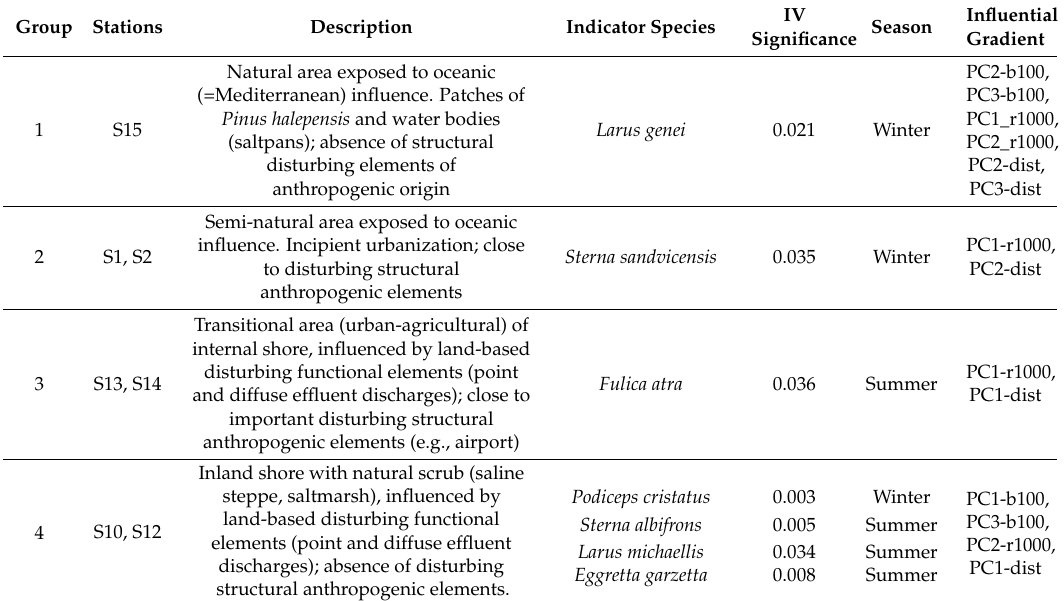
Table 3. Sampling stations grouped by Cluster classification (structural-functional groups) from the first three axes of all the PCAs performed. Also shown are the Indicator Species for each group (from IndVal analyses), the season when the indicator value is statistically significant and the influential environmental gradients (PCs) for each species (clear association of preferred stations with axes).